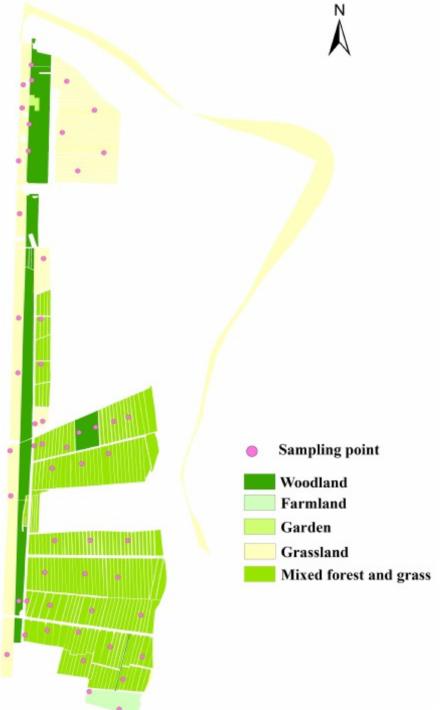
Figure 3. Distribution of sampling